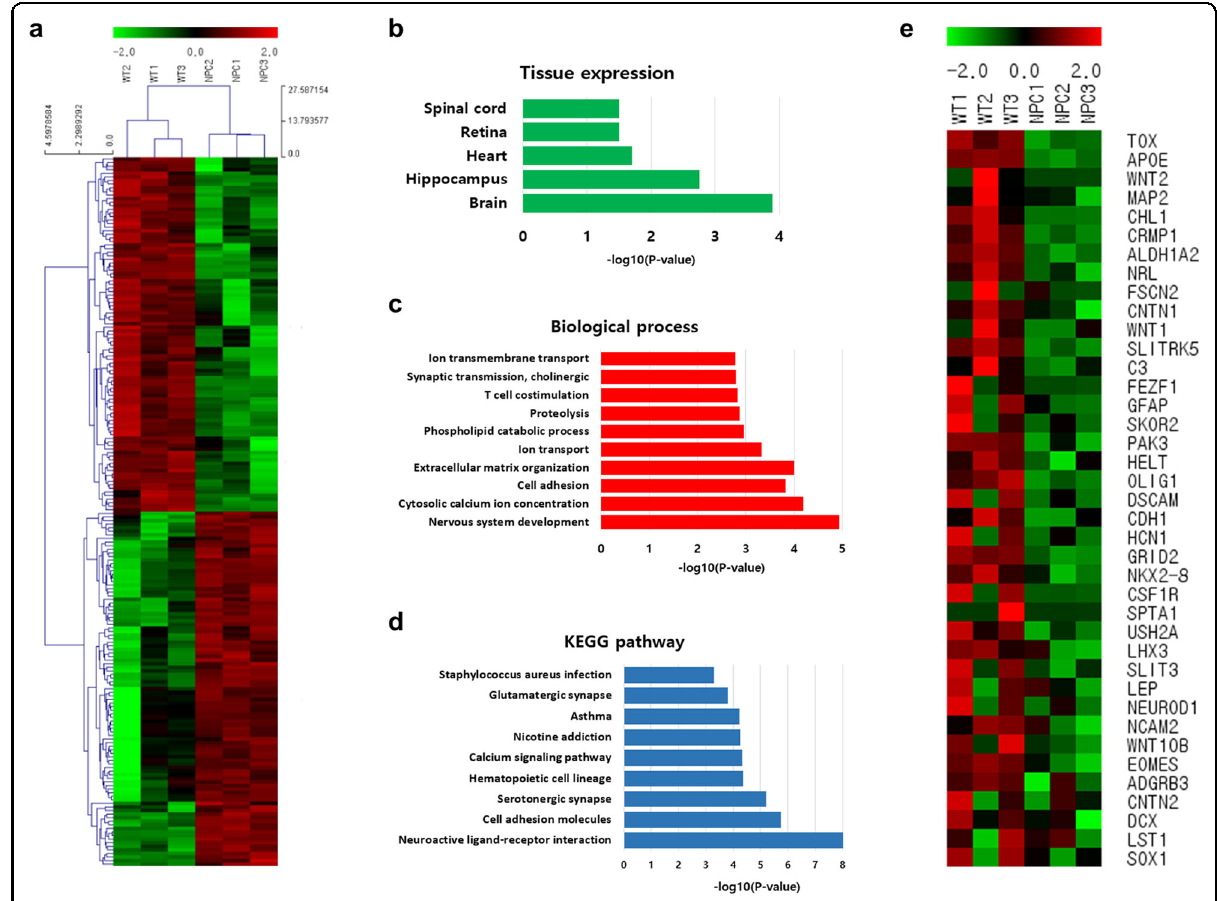
Fig. 5 Gene expression analysis of WT organoids and NPC disease organoids. a Differentially expressed genes in the WT and NPC organoids at day 28. Heat maps of the z -score values of RNA-Seq in the WT and NPC organoids on day 28. Three samples were prepared from each group. b Top fi ve tissue with enriched expression of the top 1000 genes that were upregulated in the WT organoids compared with the NPC organoids at day 28. c The top 10 highest ranked biological process categories were plotted according to p value. d KEGG pathways were plotted by selecting the top nine terms ranked according to p value. e Top 20 genes that were signi fi cantly upregulated in the WT organoids compared with the NPC organoids at day 28, presented as a heat map of z -score values. Three samples from each group are